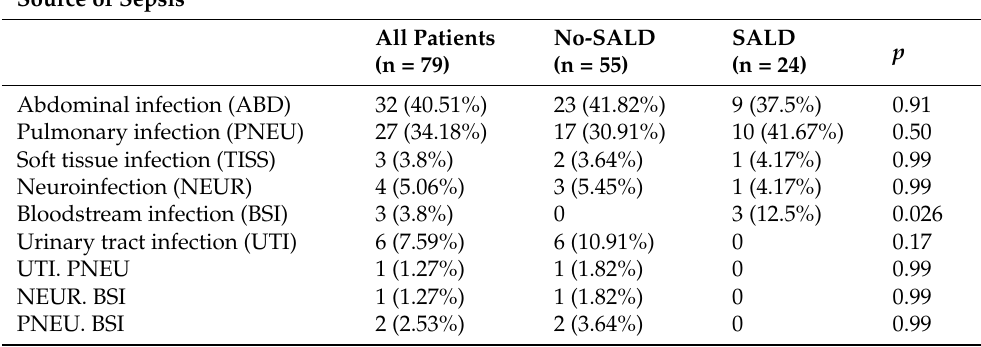
Table 3. Source of